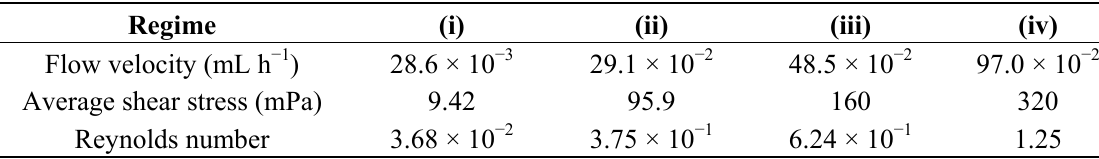
numbers and average shear rates applied to